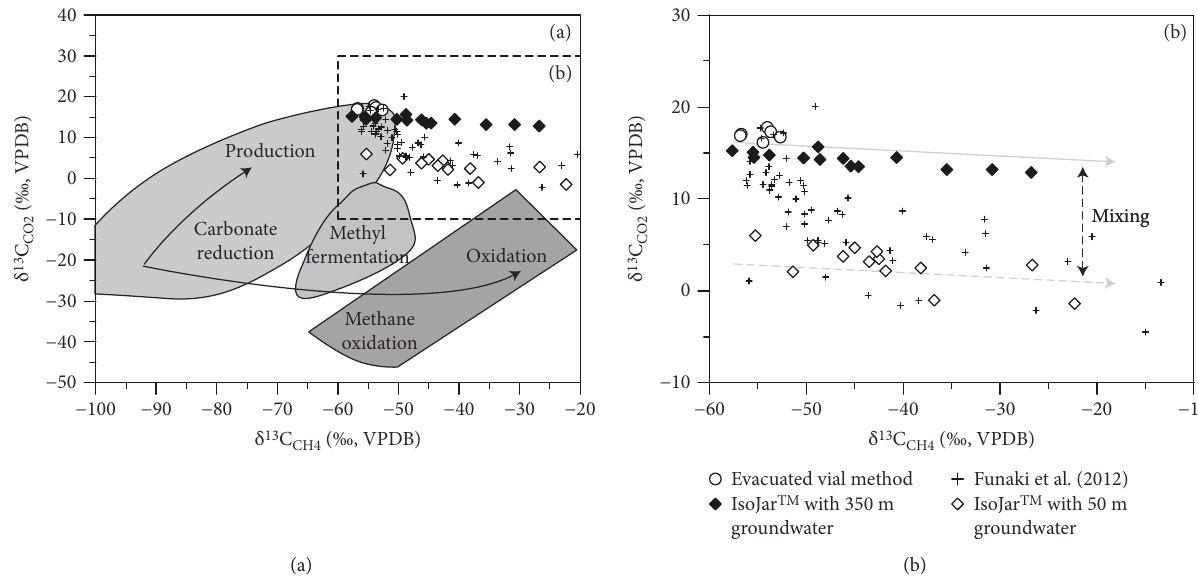
Figure 6: Plot of δ 13 C vs. δ 13 C in coexisting gases. (a) Grey areas show fi elds relating to di ff erent gas sources and isotopic shifts CH4 CO2 resulting from production and oxidation (adapted from [50]). The area indicated by the dashed rectangle is enlarged in (b). (b) Solid arrow indicates a methane oxidation trend for samples with 350 m groundwater; dashed arrow indicates the trend for samples with 50m groundwater.